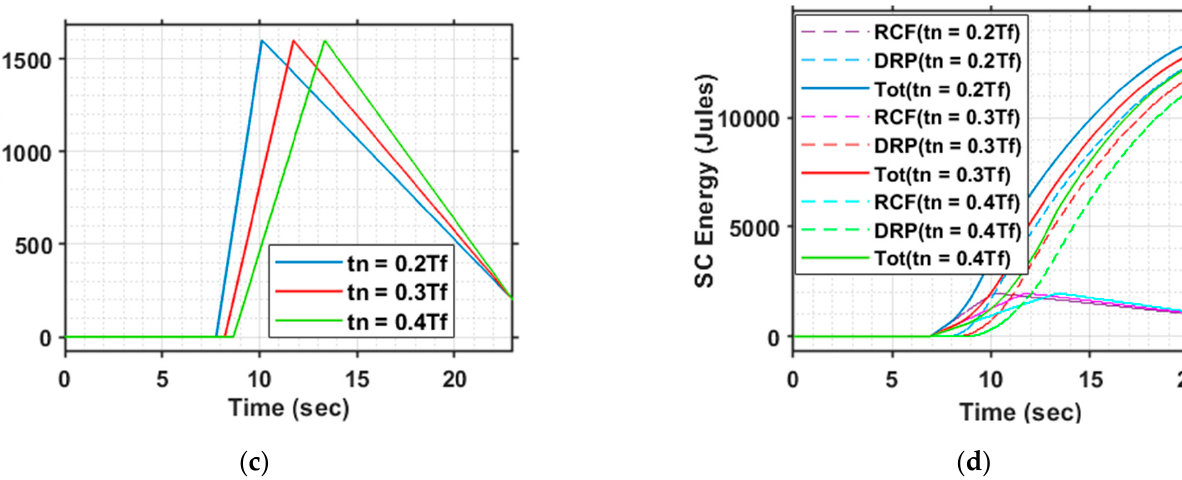
Figure 18. Verification of the proposed TPL technique for different positions of t f storage system, conducted through MATLAB simulation, for all three cases: ( a ) PFR characteristics; ( b ) RoCoF subjected to variation in frequency; ( c ) estimated SC power; ( d ) estimated SC energy showing the energy corresponding to RoCoF, Droop control and the total energy,